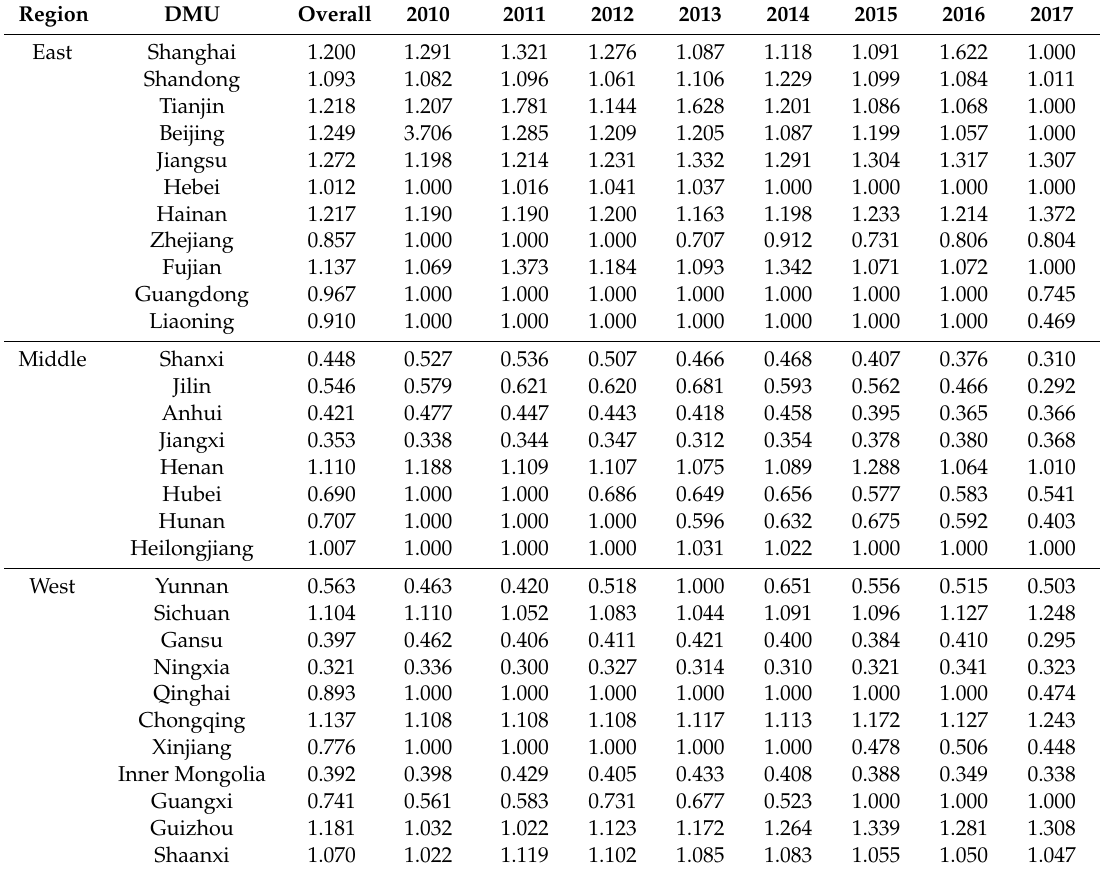
Table 4. Overall e ffi ciency by provinces from 2010 to 2017